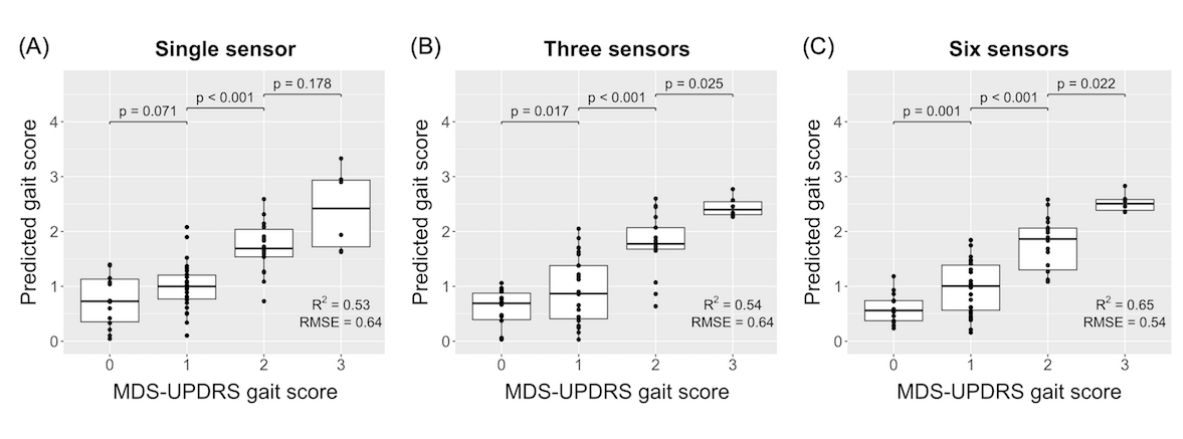
Figure 2. MDS-UPDRS gait score model performance fit using gait features from (A) single device at the lumbar (L5) location (GaitPy), (B) 3 devices (APDM Mobility Lab), and (C) 6 devices (APDM Mobility Lab). MDS-UPDRS: Movement Disorder Society version of the Unified Parkinson Disease Rating